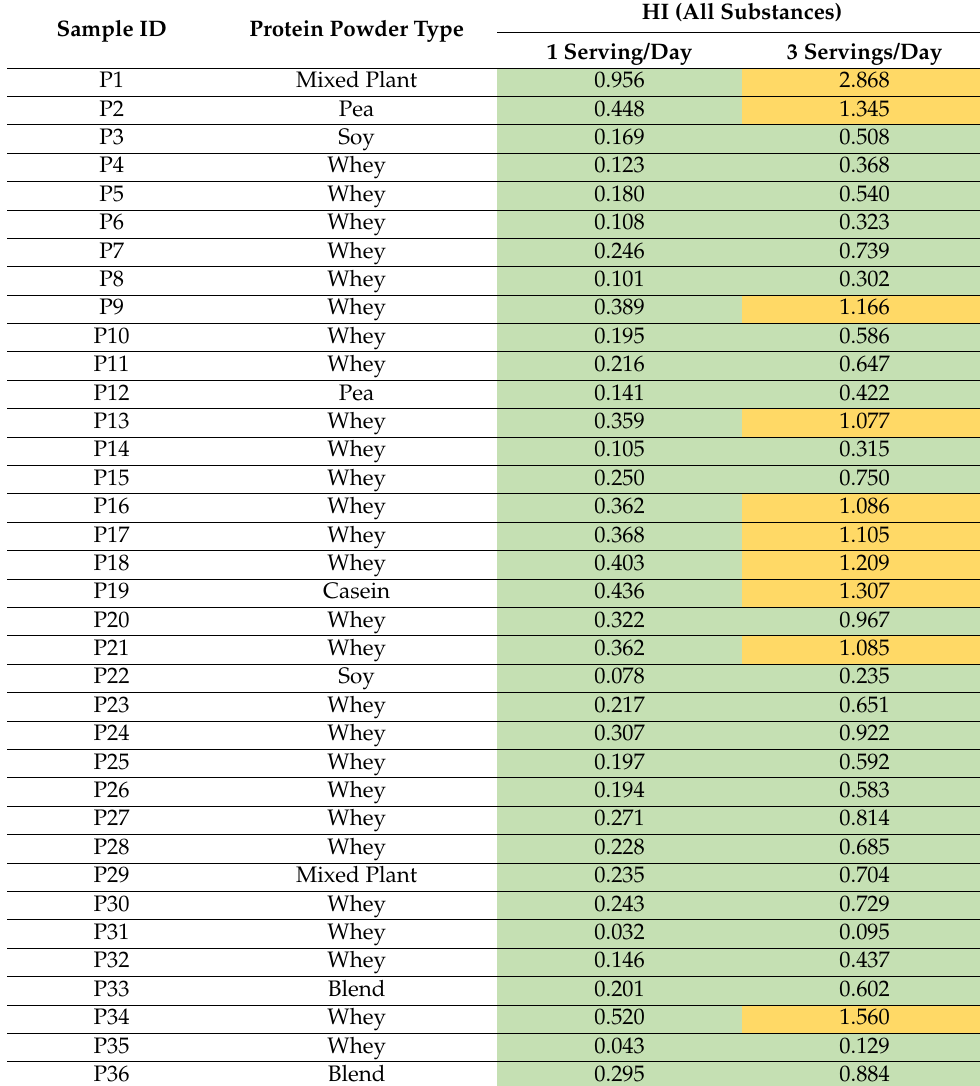
Table 7. Calculated hazard index (HI) values for each protein powder sample (potential exposure for a 70 kg